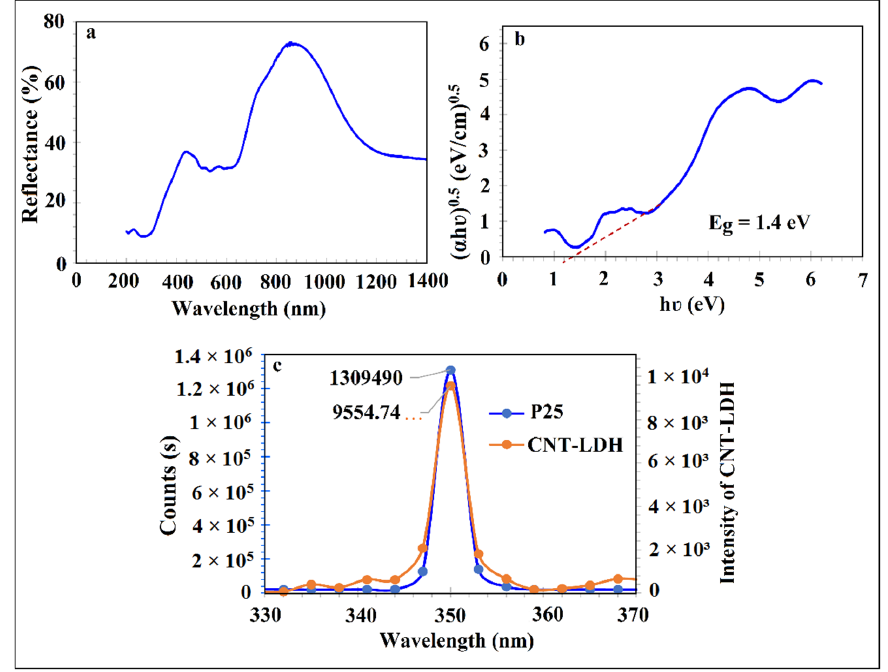
Figure 8. ( a , b ) The typical IR-responsivity of CoTi-LDH and ( c ) the corresponding PL compared to conventional P25.